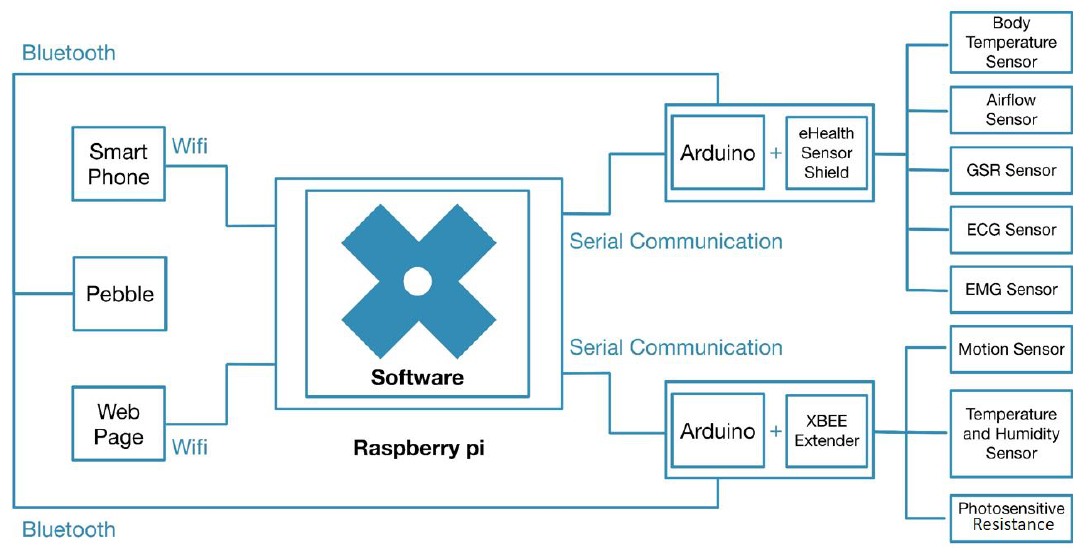
Figure 3. System architecture including health wearable